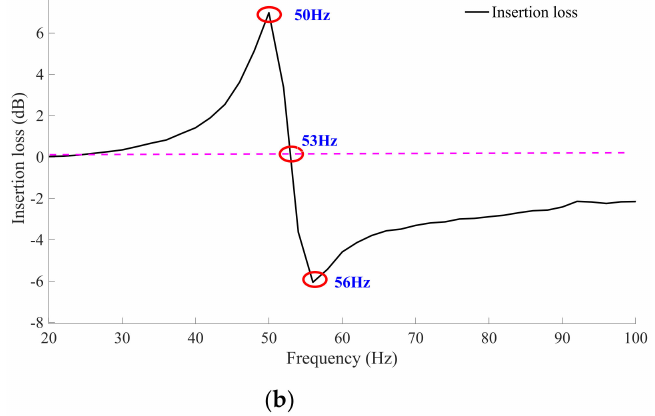
Figure 11. Sound pressure level and insertion loss at field point 3; ( a ) sound pressure level; ( b ) inser- tion loss.